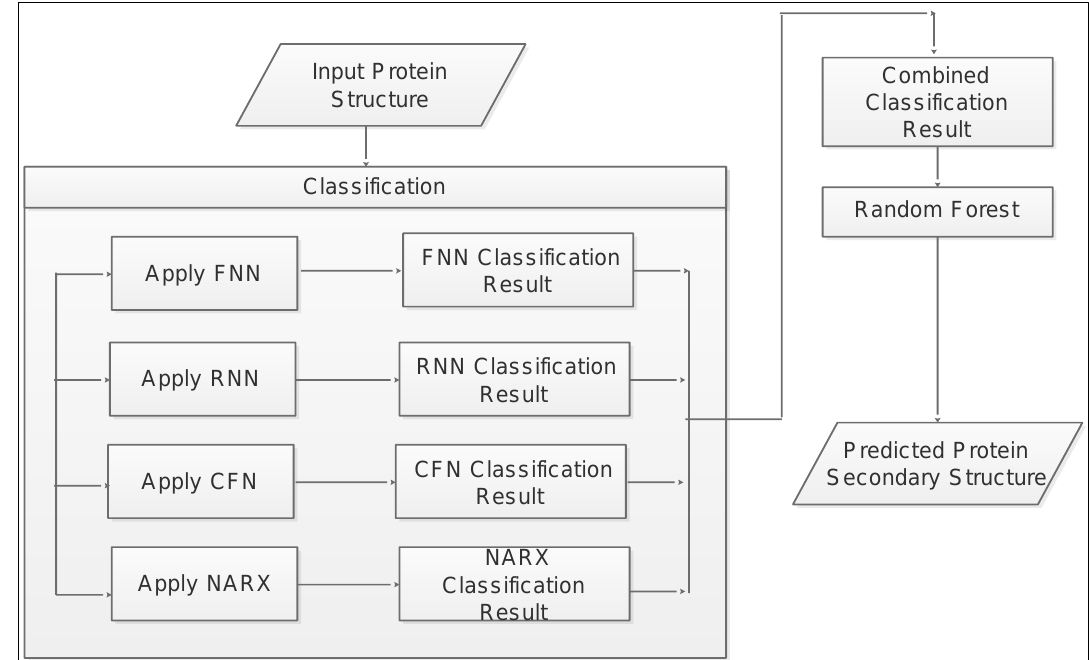
Figure 6: Proposed Ensemble